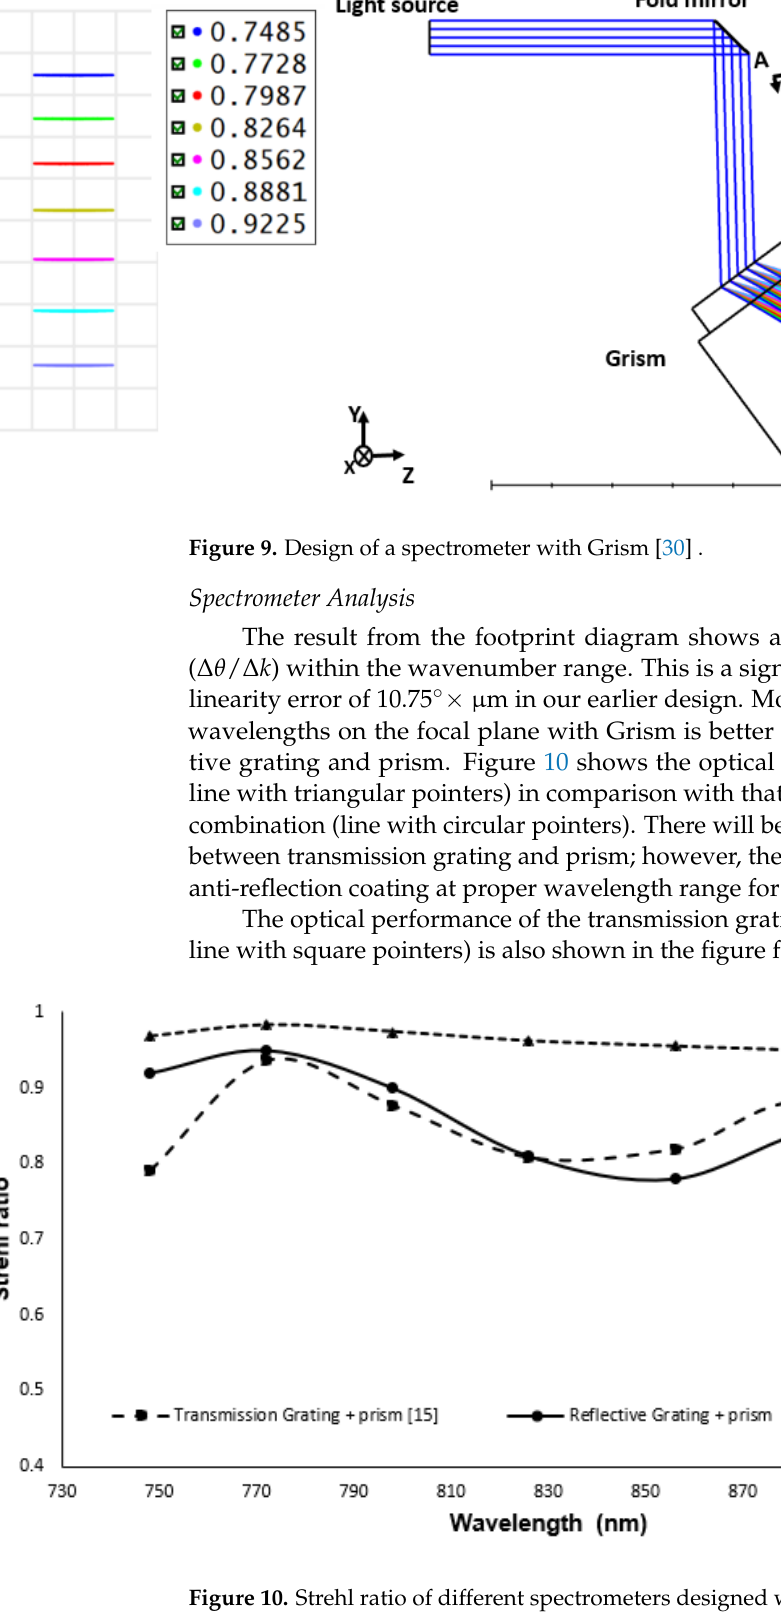
Figure 10. Strehl ratio of different spectrometers designed with reflective grating and prism, trans- mission grating and prism and